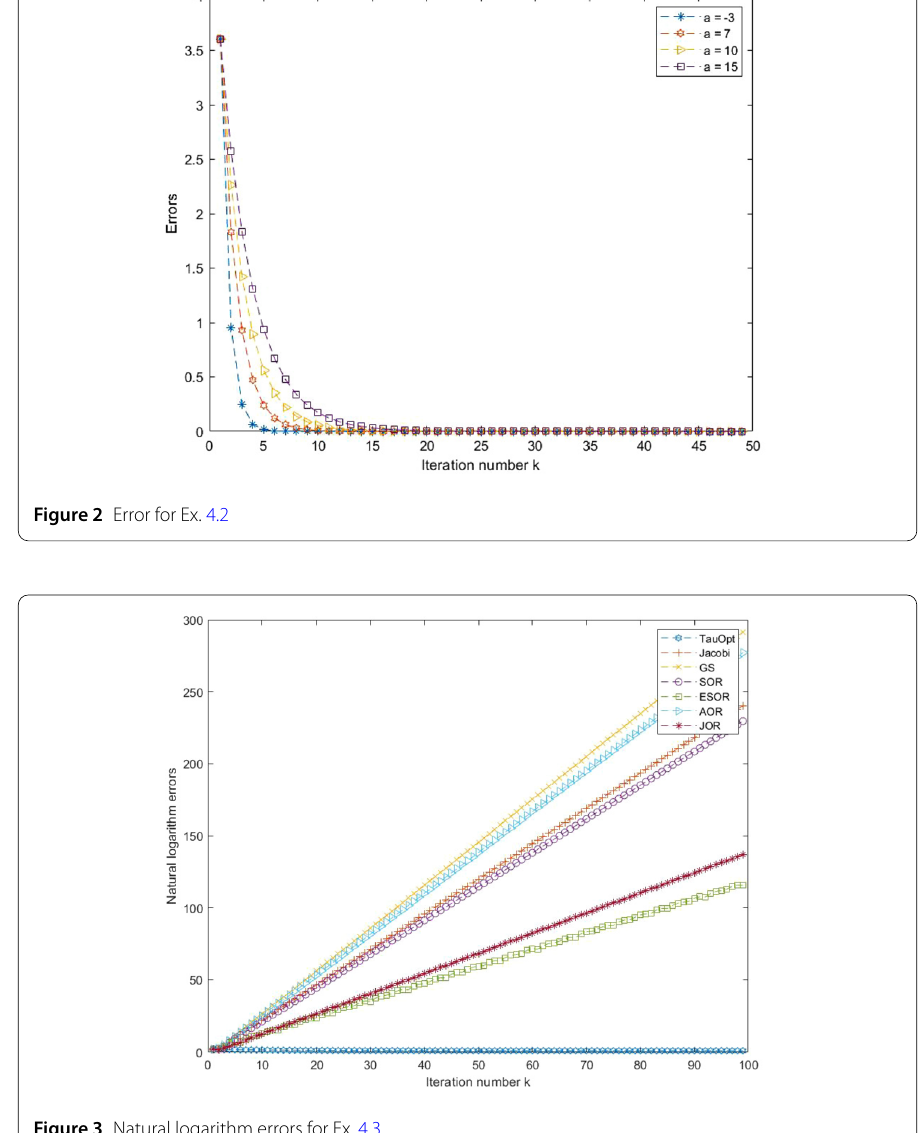
Figure 3 Natural logarithm errors for Ex.